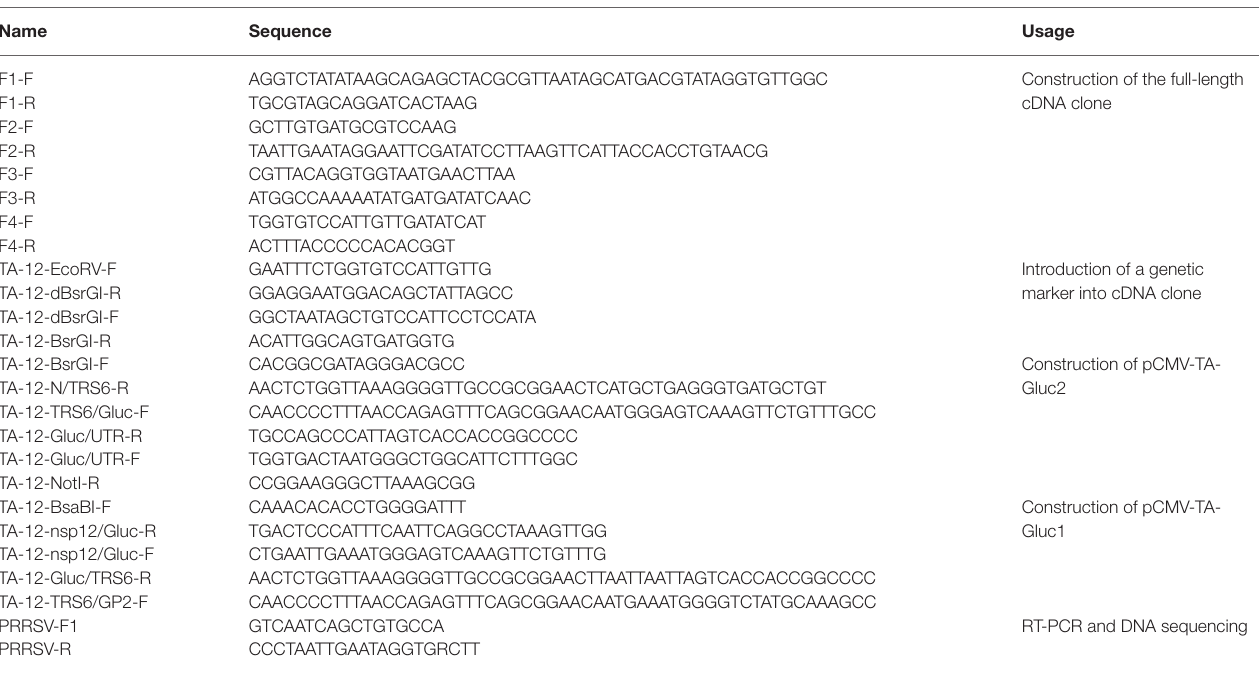
TABLE 1 | The primers used in this